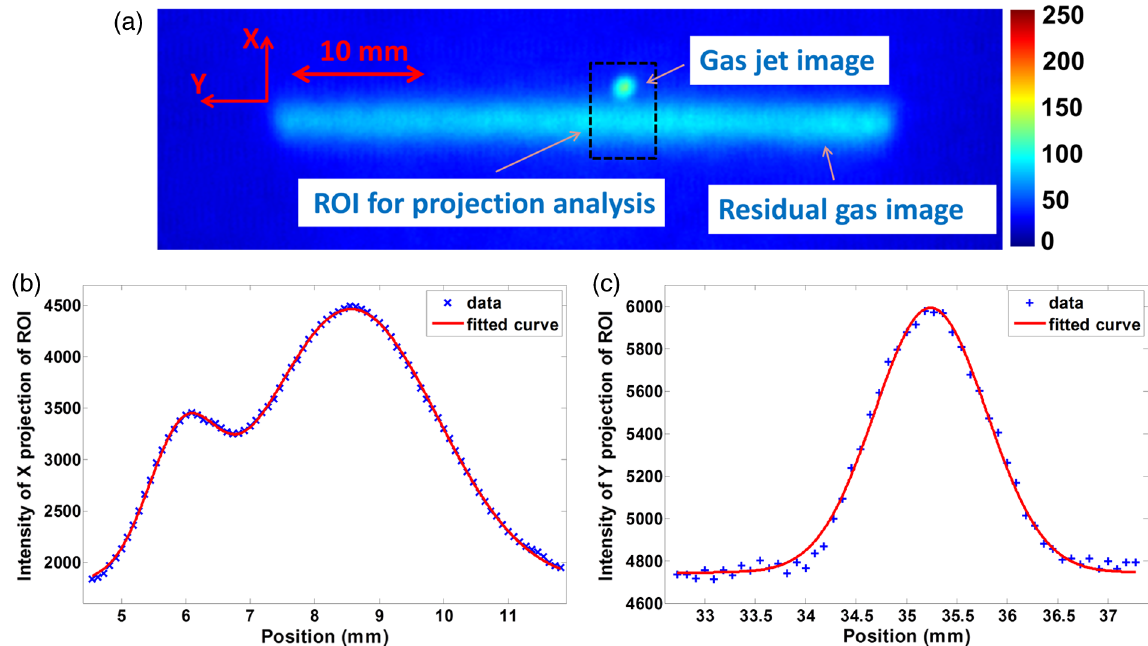
FIG. 17. (a) Images of the electron beam profile from both gas jet and residual gas; projected profiles in (b) x direction and (c) y direction (electron beam energy is 3.5 keV, external collecting E-field is 8 . 0 kV = m, the gas pulse duration time is 1 s, and the exposure time of the camera is 120 ms in the middle of the pulse).